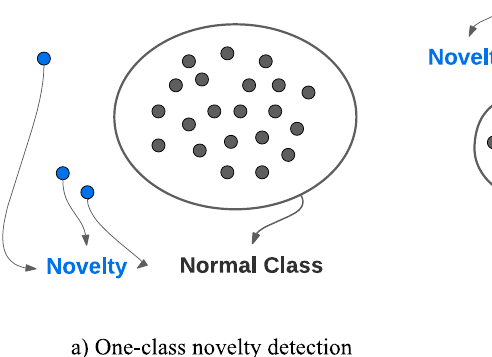
Figure 16. One-class and multi-class novelty